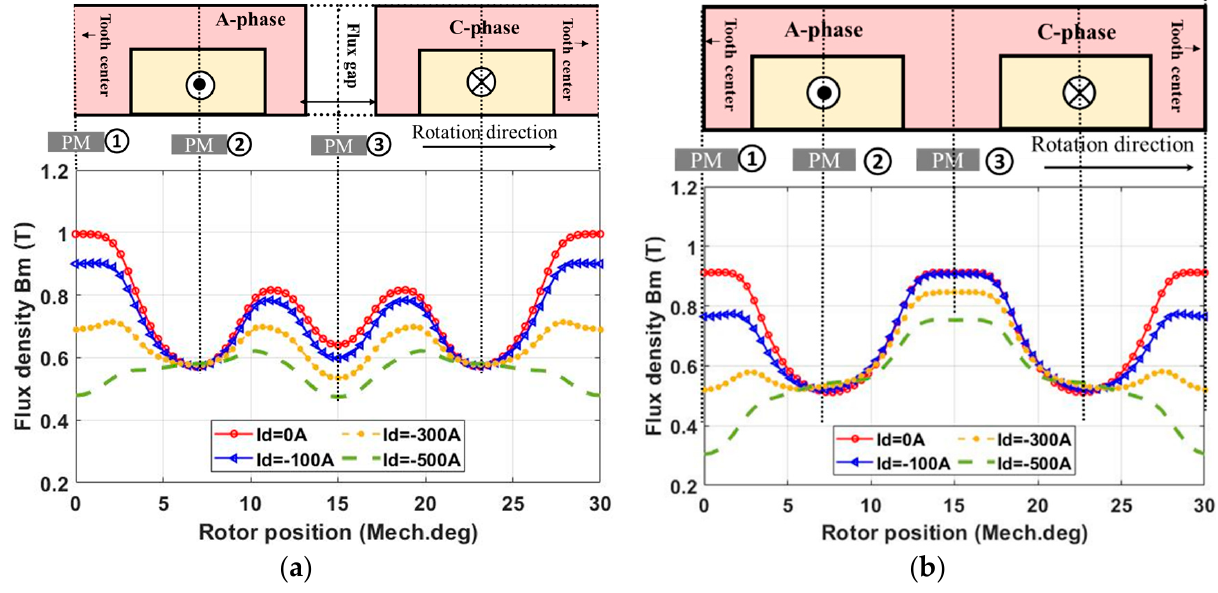
Figure 8. Magnet flux density (radial component) at 20 °C at point A for the ( a ) modular and ( b ) non-modular machines.